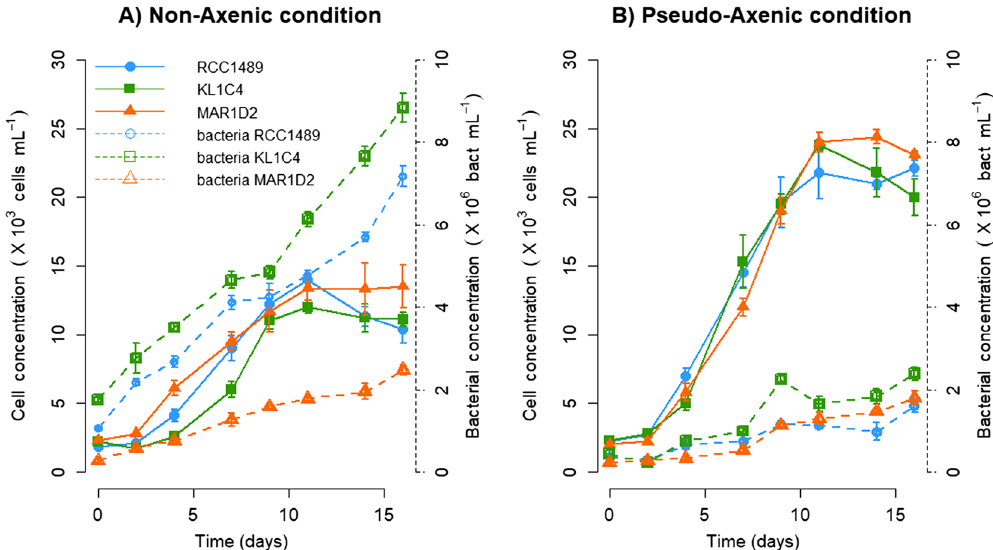
Figure 1. Lepidodinium chlorophorum concentrations (cell mL −1 ; solid lines) and bacterial concentrations (bacterial cell mL −1 ; dashed lines) for the three L. chlorophorum strains analysed under ( A ) non-axenic (NA) and ( B ) pseudo-axenic (PA) culture conditions. Symbols represent means and error bars represent the standard deviations from triplicate